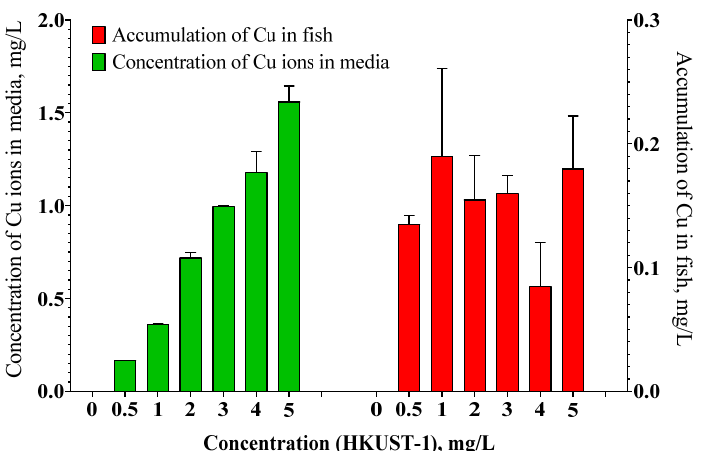
Figure 5. Accumulation of copper in internal organs of zebrafish adults (liver, spleen, gastrointestinal tract) after 24 h of exposure (red) and copper ions concentration in water at the end of the experiment (green). Results expressed as mean ± standard deviation of duplicate tests.